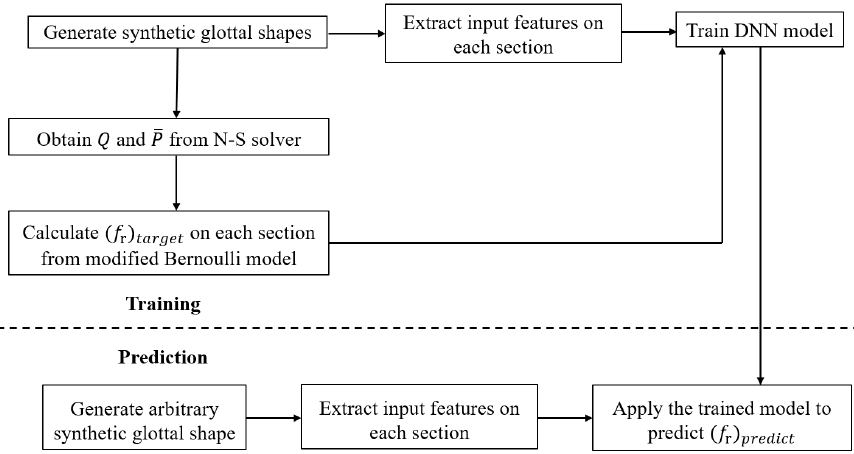
Figure 2. Workflow of training and